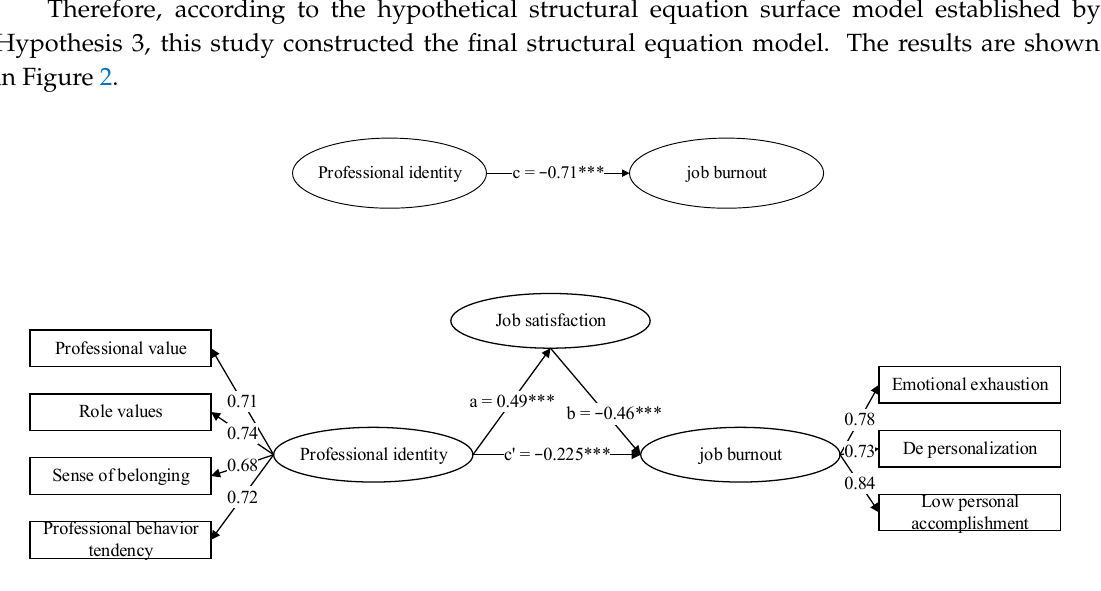
Figure 2. Path map of mediating role of job satisfaction. *** p < 0.001.